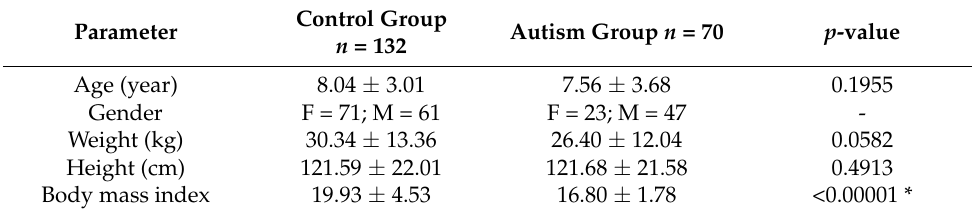
Table 6. Clinical characteristics of patients with autism and controls from Eastern Province, Saudi Arabia. Control Group Autism Group n = 70 p -value Parameter n = 132 Age (year) 8.04 ± 3.01 Gender F = 71; M =